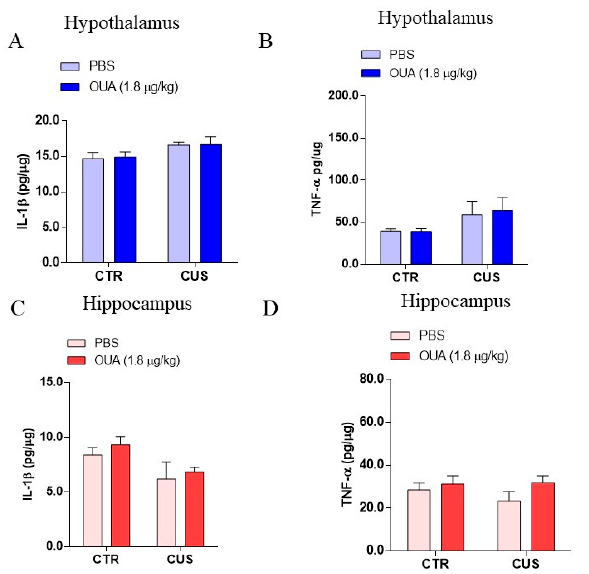
Figure 3. Effect of chronic unpredictable stress (CUS) on levels of pro-inflammatory cytokines in the hypothalamus and hippocampus. ( A , B ) Show levels of the hypothalamus (blue bars) (IL-1 β ( n = 5) (F (1, 16) = 4.914; p = 0.0415 for CUS factor. F (1, 16) = 0.03912; p = 0.8457 for treatment factor) and TNF- α ( n = 9–10) (F (1, 34) = 4.338; p = 0.0449 for CUS factor. F (1, 34) = 0.04273; p = 0.8375 for treatment factor). ( C , D ) Levels of hippocampal (red bars) IL-1 β ( n = 5) (F (1, 16) = 6.002; p = 0.0262 CUS factor. F (1, 16) = 0.7027; p = 0.4142 for treatment factor) and TNF- α ( n = 8–10) (F (1, 30) = 0.3623; p = 0.5518 for CUS factor. F (1, 30) = 2.289; p = 0.1408 for treatment factor). Data are presented as mean ± SEM (a two-way ANOVA, followed by Newman–Keuls post hoc test, revealed a significance for TNF- α from HP, or Kruskal–Wallis test, followed by Dunn’s post hoc test, for IL-1 β from HT and HP). Figure 4. Chronic intermittent treatment with ouabain reduces iNOS activity in the hippocampus of animals submitted to CUS. ( A – C ) The activity of tNOS (F (1, 15) = 0.3099; p = 0.5860 for CUS factor. F (1, 15) = 0.1208; p = 0.7330 for treatment factor), nNOS (F (1, 16) = 0.6990; p = 0.4154 for CUS factor. F (1, 16) = 1.475; p = 0.2421 for treatment factor), and iNOS (F (1, 16) = 6.753; p = 0.0194 for CUS factor. F (1, 16) = 0.3043; p = 0.5888 for treatment factor) were not altered in the hypothalamus of the differ- ent groups studied ( n = 5) (blue bars). ( D , E ) The graphs show that there was no change in NOS total (F (1, 16) = 0.7099; p = 0.4119 for CUS factor. F (1, 16) = 2.451; p = 0.1370 for treatment factor) and nNOS (F (1, 16) = 0.9158; p = 0.3528 for CUS factor. F (1, 16) = 1.991; p = 0.1774 for treatment factor) activity in the hippocampus of the different groups studied (red bars) ( n = 5). ( F ) CUS increased iNOS activity, relative to control groups that were reduced by OUA treatment in the hippocampus (F (1, 16) = 0.6989; p = 0.4155 for CUS factor. F (1, 16) = 5.871; p = 0.0276 for treatment factor), # p <